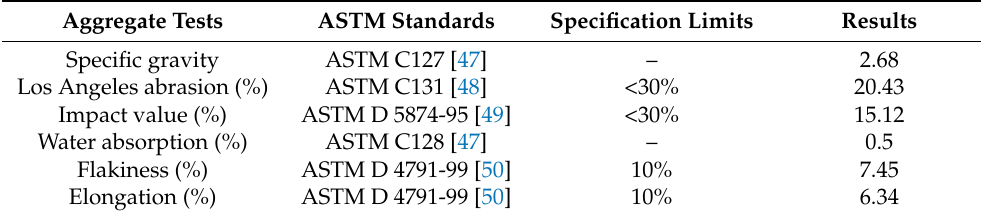
Figure 1. Coarse aggregates used in the study. Table 1. Properties of the aggregates with standard specifications.